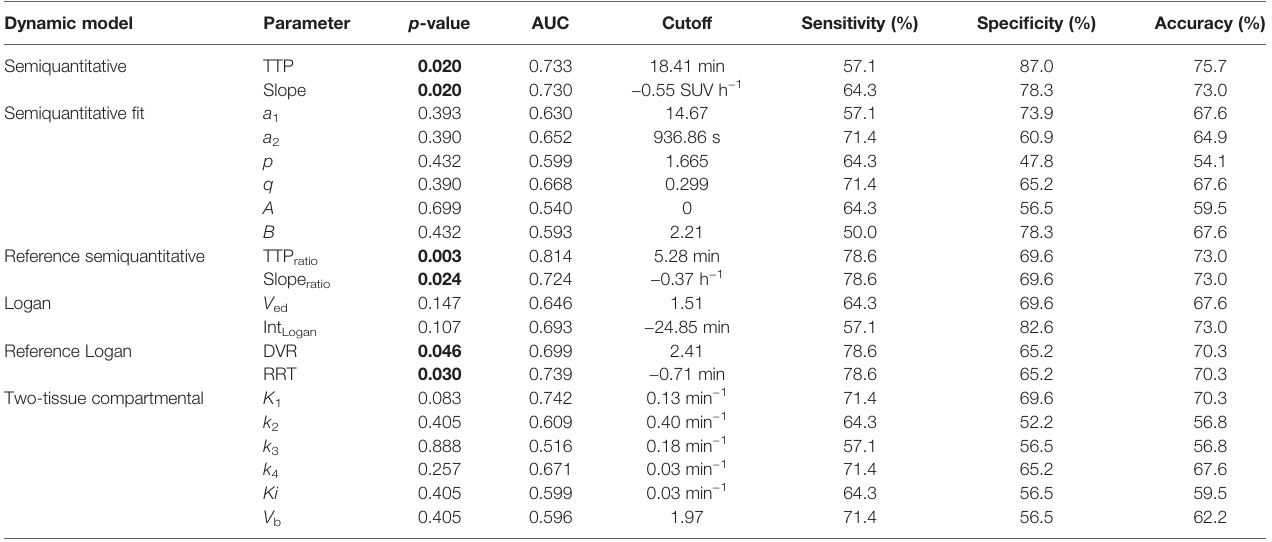
TABLE 2 | Results of the receiver operating characteristic (ROC) curve analyses for predicting isocitrate dehydrogenase (IDH) mutations using individual parameters. Dynamic model